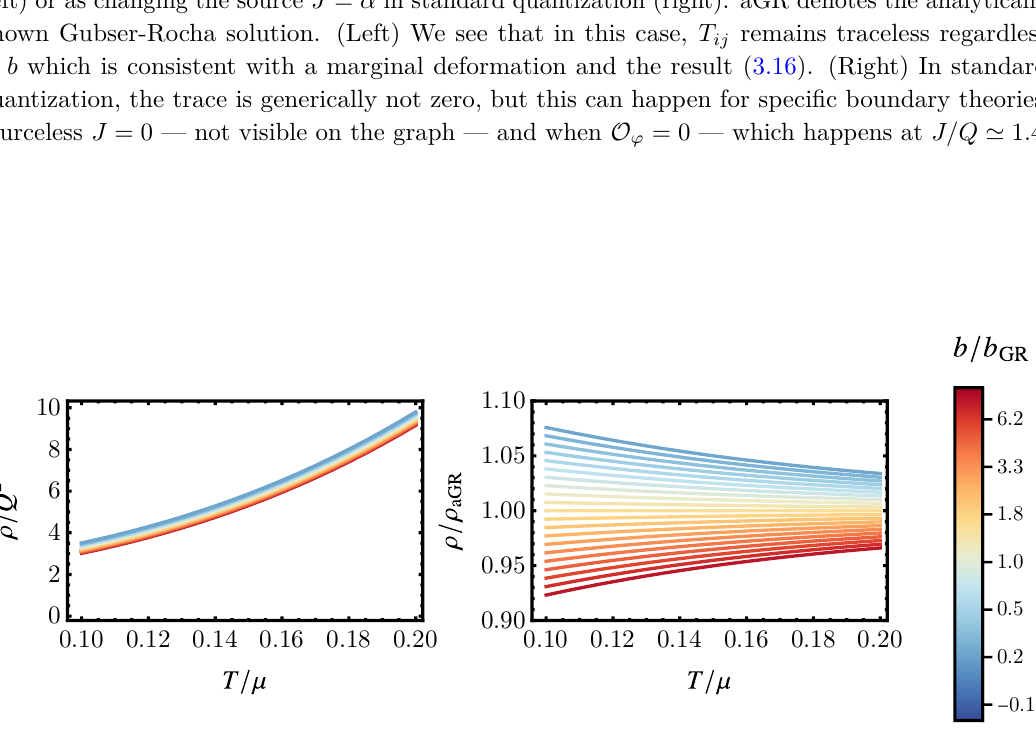
Figure 4 . Boundary charge density as a function of the temperature T/µ when imposing Dirichlet boundary conditions, which we interpret as varying the boundary theory through b . The charge density is normalized by Q 2 in the left-hand plot and by its aGR value defined in (3.24) in the right-hand plot. The qualitative behaviour of all these theories is extremely similar to the aGR solution (left) but quantitatively differs as a function of T/µ (right), showing the theories described are